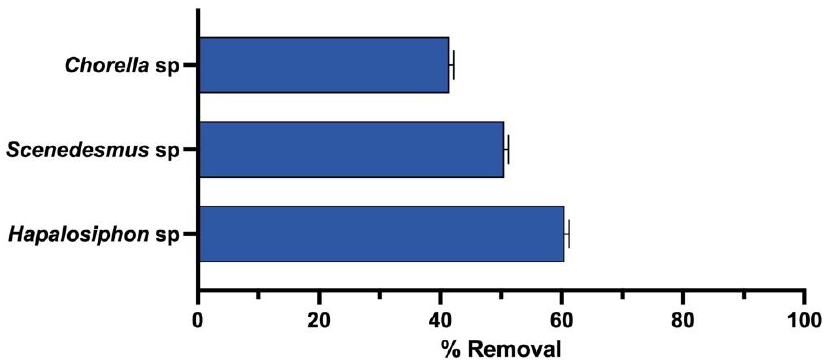
Figure 4. Chlorpyrifos removal by the three strains was evaluated.